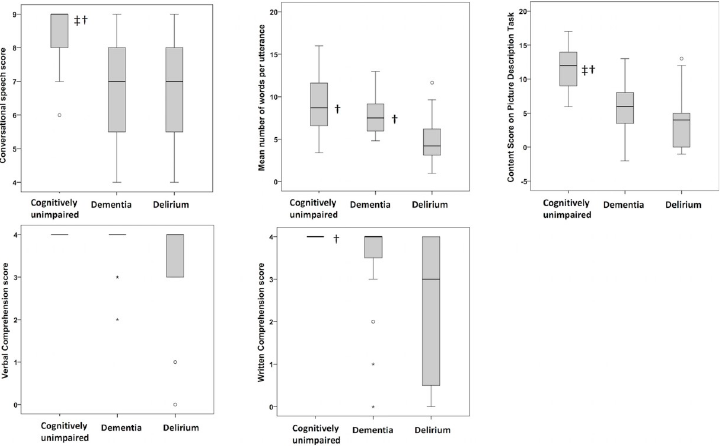
Fig 1. Group results for the conversational speech assessment (A), the average number of words per utterance (Cookie Theft picture task) (B), the content score (Cookie theft) (C), verbal comprehension score (D) and written comprehension score (E). The interquartile range and median value of each dataset are represented by the height of the inner box and the position of the central horizontal line, respectively. The positions of the upper and lower bars of each plot indicate the maximum and minimum non-outlier values of each dataset. Any outliers are represented by open circles on the plot. Symbols to the right of the median lines indicate group scores that differ significantly from delirium (†) or dementia